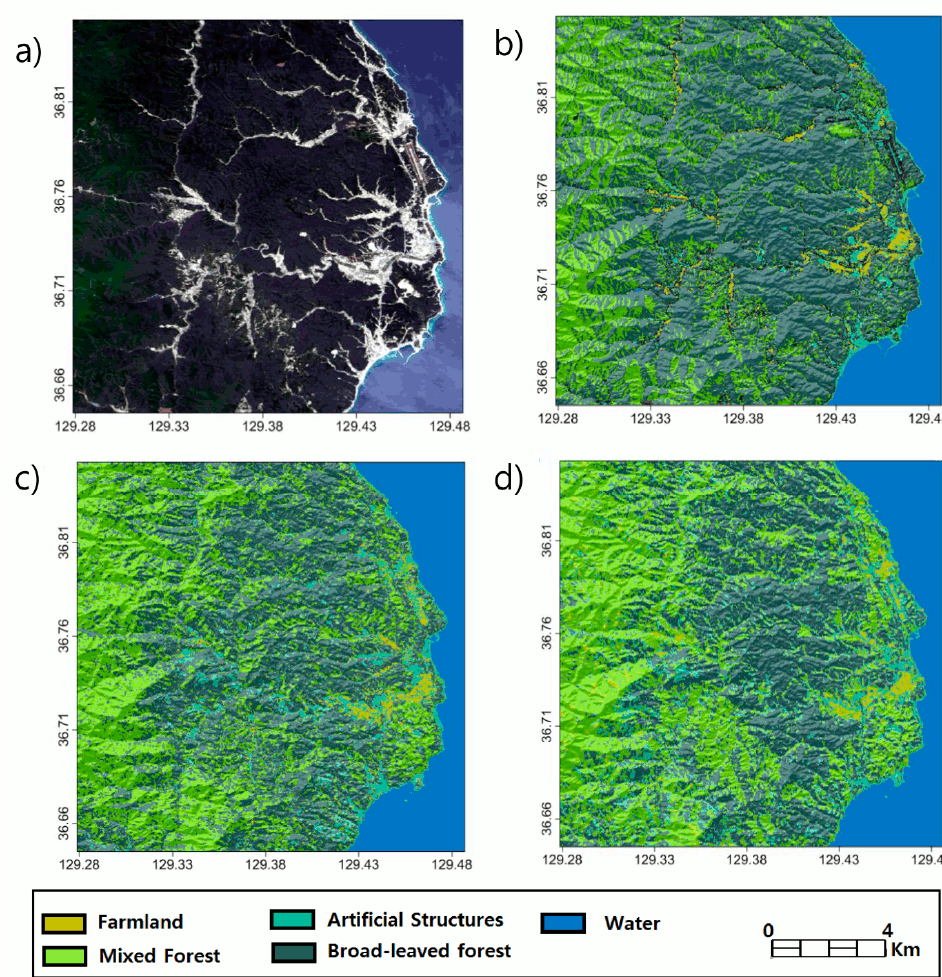
Figure 9. Landsat 8 visual channel image ( a ) and the land cover classification map ( b ) over Uljin target area. ( c ) and ( d ) respectively illustrate the land cover classifications conducted using k-PCA plus SVM scheme based on HH1 packet during 2009/07–2010/03 and HH2 packet during 2010/10–2011/03. Table 5. Confusion matrix of k-PCA/SVM classification scheme over Uljin.